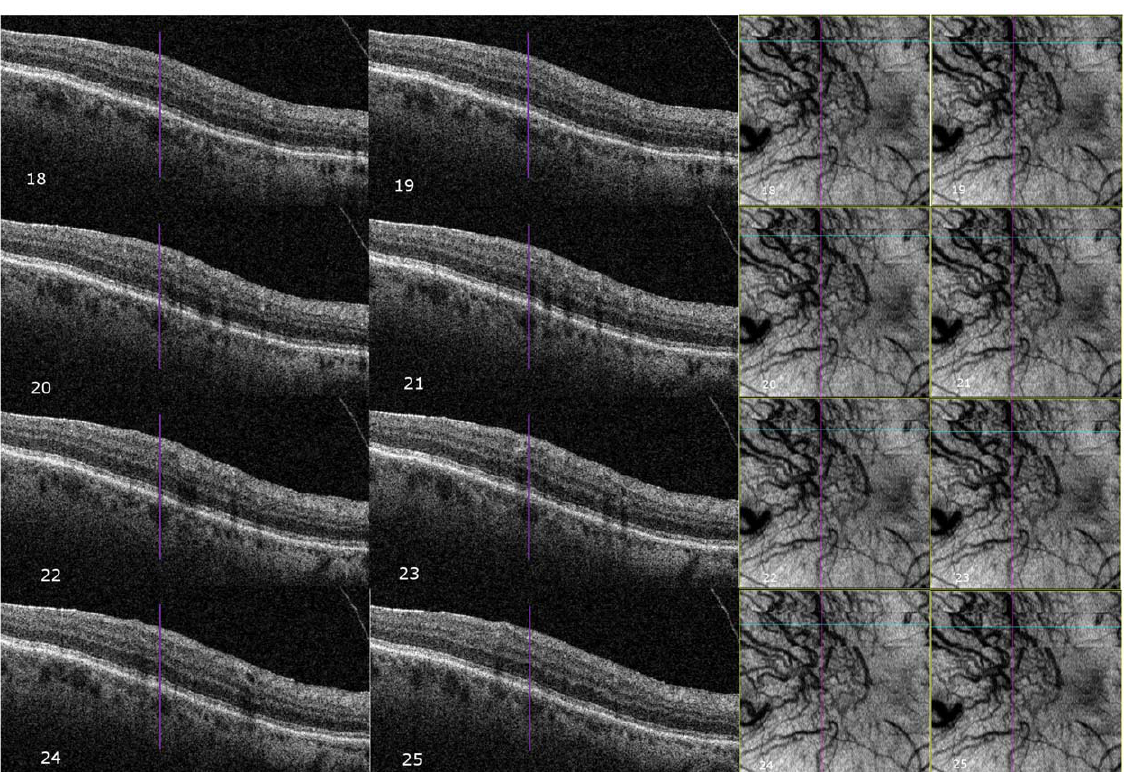
Figure 4. Cross-Correlation of Choroidal Vascular Appearance on Optical Coherence Tomography (OCT) Comparing B- and C- Scans. A large choroidal vessel is identified as a well-defined round hypo-reflective structure in cross-section on individual B-Scans (purple line). Sequential B-scan slices (18–25) are shown with the purple line centered on the same choroidal vessel. On the C-scans shown, the blue horizontal lines correspond to the location of the respective B-scan, while the purple line follows the vertical axis of the corresponding choroidal vessel on C- scan.